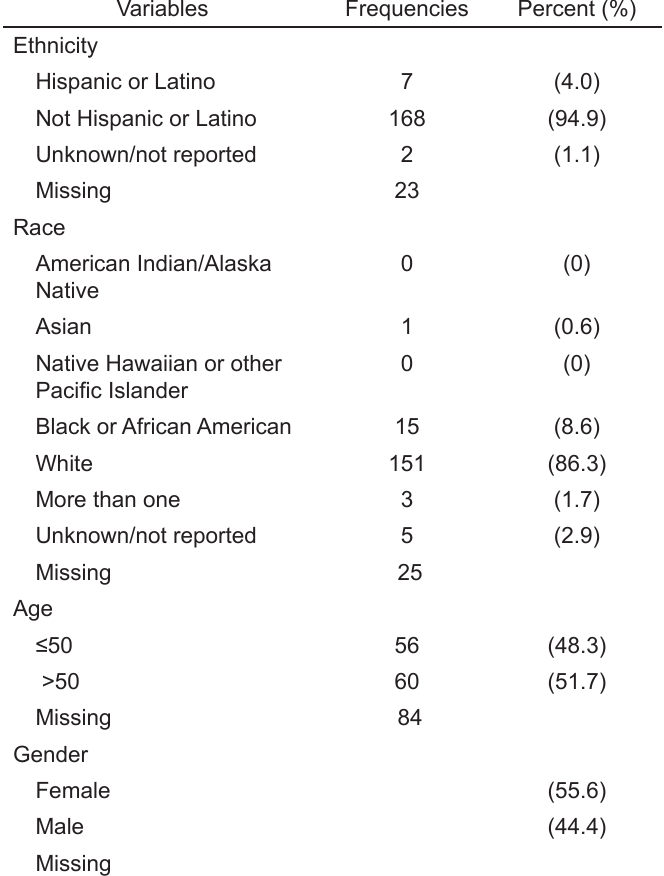
Table. Characteristics of patients who completed a survey that assessed social risks.